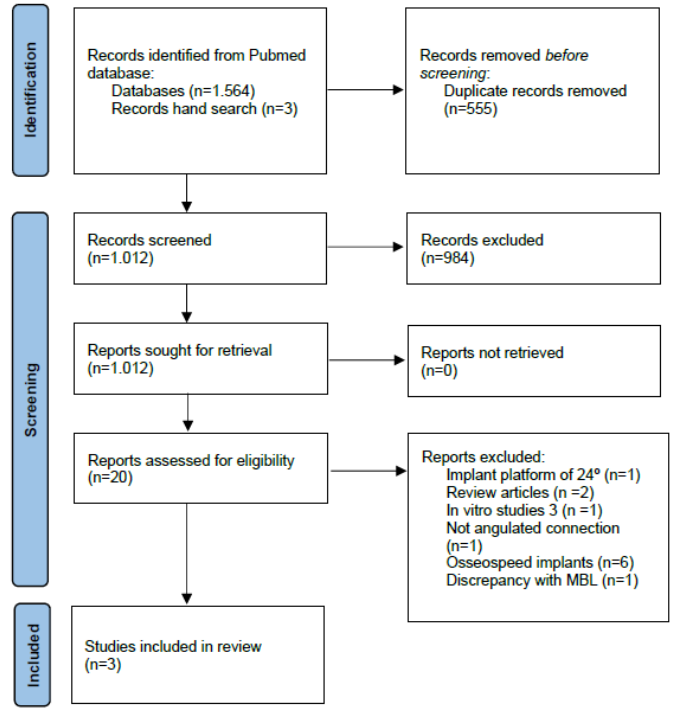
Figure 2. PRISMA flowchart of the screening process [17].